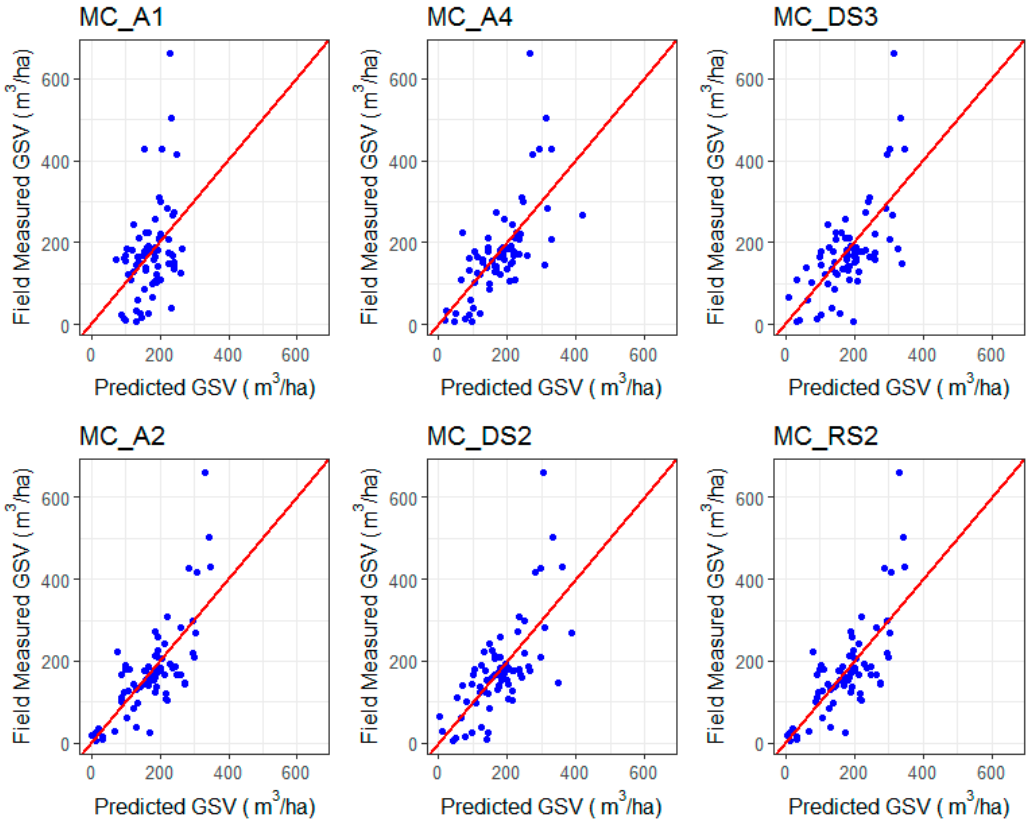
Figure 7. Scatter plot of field measured GSV versus predicted GSV for models fitted using MC based predictor variables.